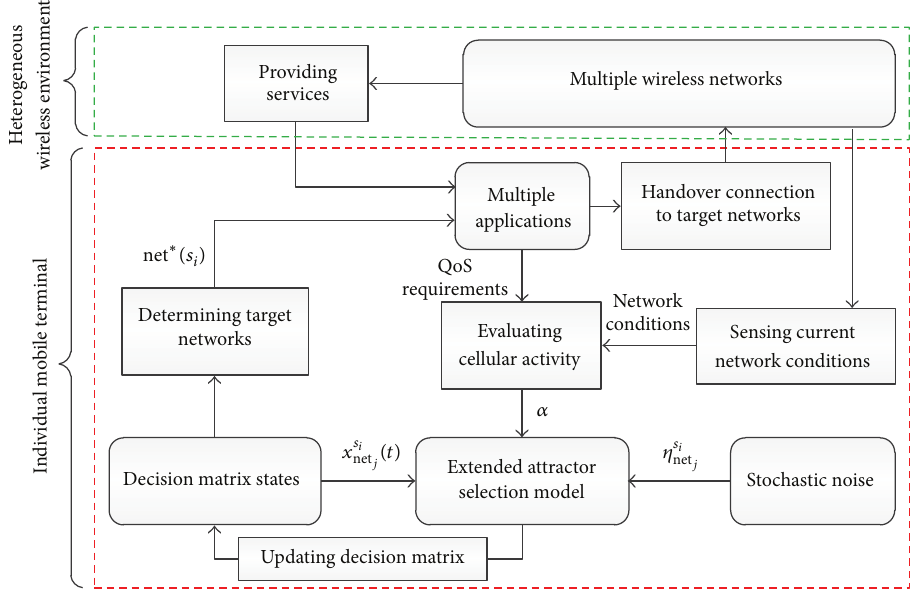
Figure 3: The handover decision framework based on the extended attractor selection model.